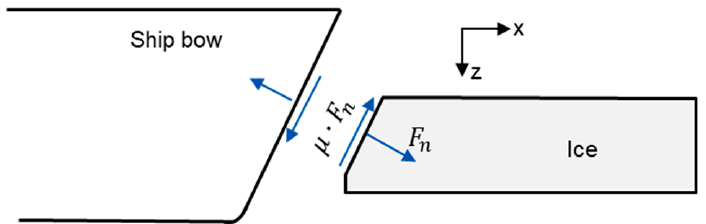
Figure 10. The force components at contact area.